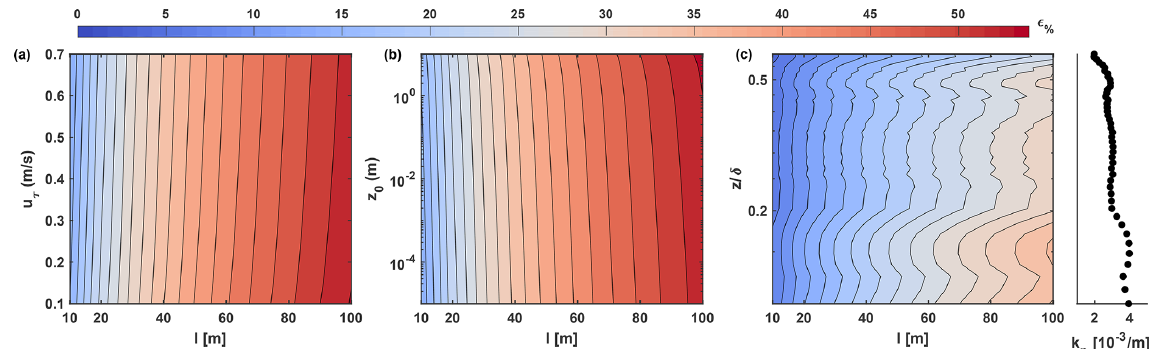
Figure 13. Variation of the percentage variance damping, (cid:15) % , connected with the lidar spatial averaging for different probe lengths and wind conditions: (a) variability with the friction velocity, u τ , (b) variability with the aerodynamic roughness length, z 0 , and (c) variability with sampling height, z . The side panel of (c) reports the vertical profile of the parameter k p estimated for the SLTEST